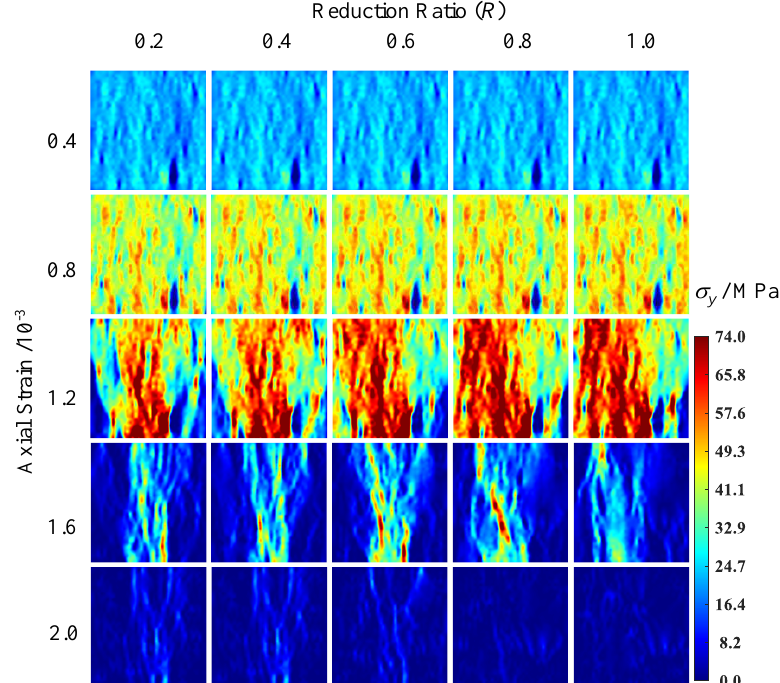
Figure 5. Mechanical properties. ( a ) Stress − strain curve; ( b ) peak stress summary graph.